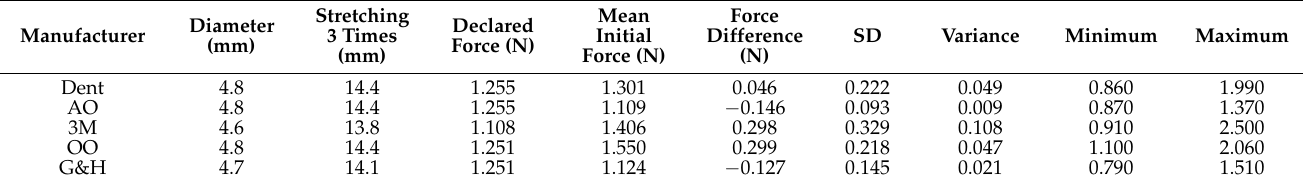
Table 1. Mean initial forces measured for elastics from five manufacturers. The diameter and declared force given by the manufacturer, and the standard deviation, variance, minimal, and maximal values are displayed in the table. “Stretching 3 times” represents the length of elastic